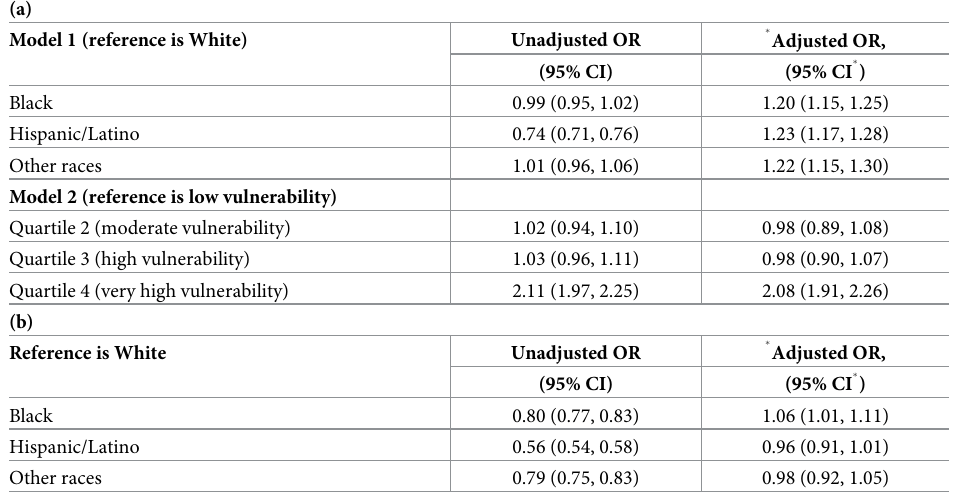
Model 1: Racial category is primary predictor. Model 2: Neighborhood type is primary predictor. � Adjusted for age group, sex, presence of comorbidity, disease severity, socioeconomic status, and county size.